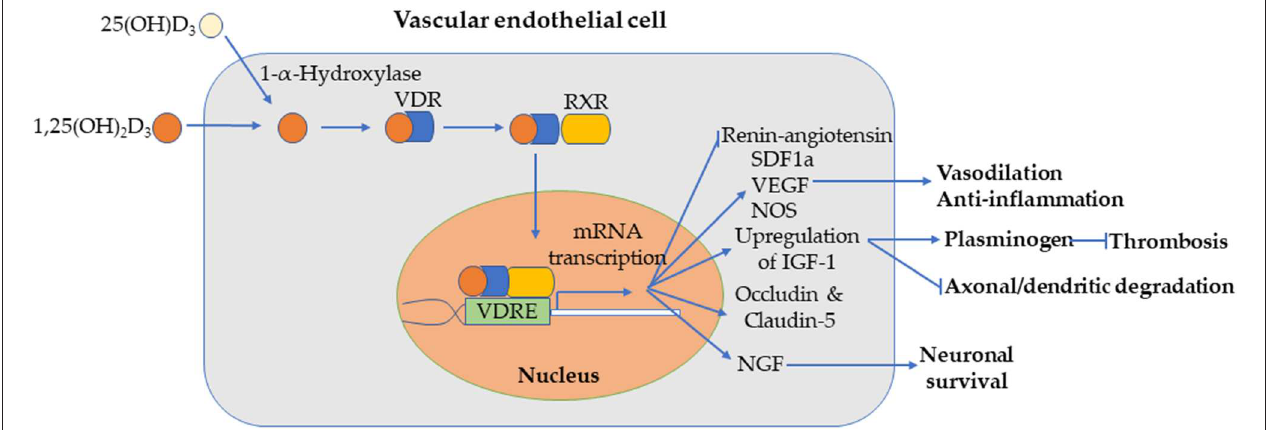
FIGURE 1 | Combination of various proposed mechanisms in endothelial cells for vitamin D prevention/mitigation of ischemic stroke. 1,25(OH) 2 D 3 [or 25(OH)D 3 D3, which is converted to of 1,25(OH) 2 D 3 via 1- α -Hydroxylase] diffuses through the endothelial cell membrane, binds to vitamin D receptor (VDR), dimerizes with RXR, and translocates into the nucleus. The complex binds to VDRE for transcription of genes resulting in inhibition of renin-angiotensin and activation of SDF1a, VEGF, and NOS pathways for vasodilation and anti-inflammation; upregulation of IGF-1 (and thus neuroprotection of axon and dendrites and thrombolysis via plasminogen);